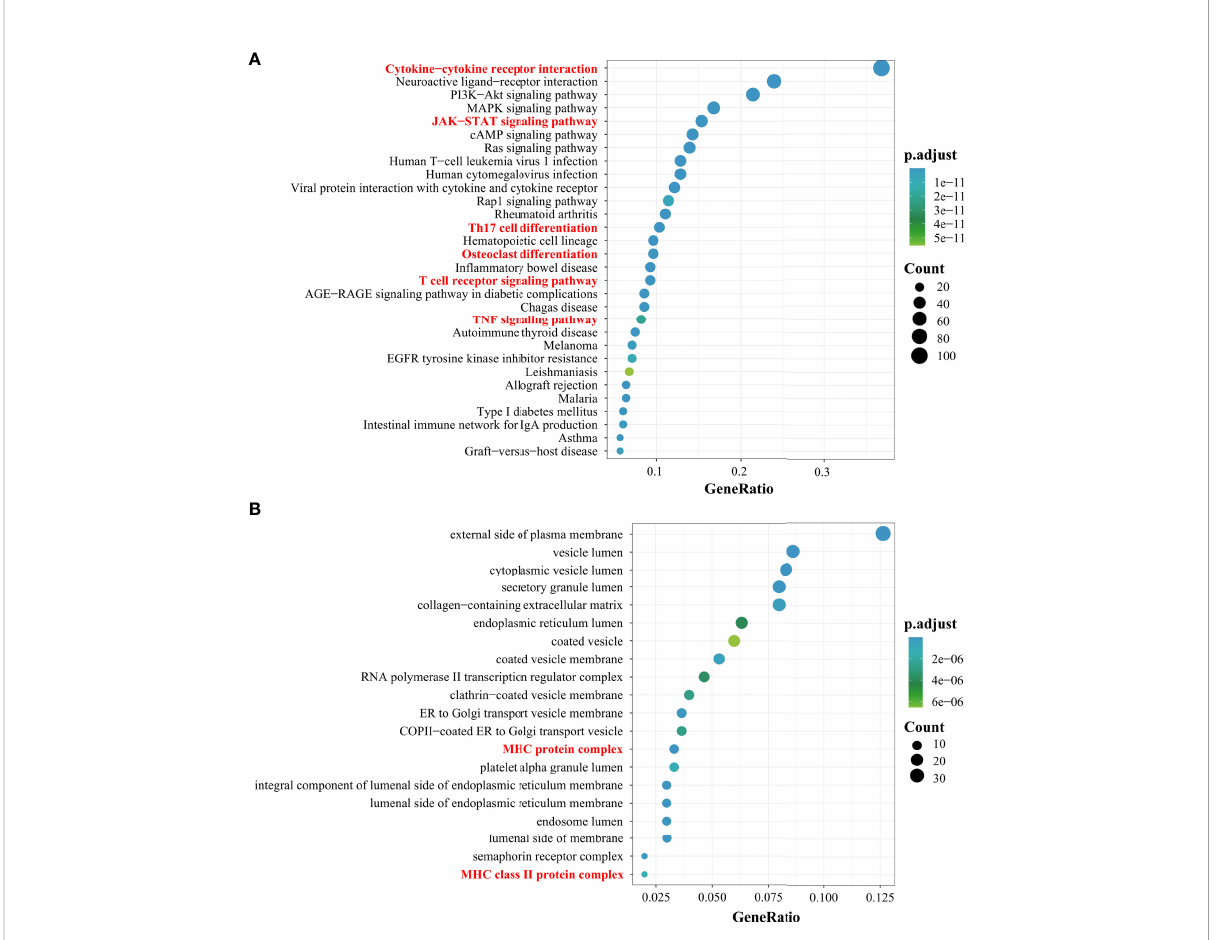
FIGURE 1 Results of the Gene Ontology (GO) and Kyoto Encyclopedia of Genes and Genomes (KEGG) analyses. The top 30 KEGG pathway enrichment candidate targets of the target genes (A) . Pathways with signi fi cant changes (FDR < 0.05) were identi fi ed. The vertical coordinates represent the KEGG pathway with signi fi cant enrichment, and the horizontal coordinates represent the gene ratio which refers to the ratio of enriched genes to all target genes. The top 20 GO enrichment candidate targets of the target genes (B) . The color of the bubble graph indicates the categories of “ cellular components ” in the GO of the target genes (FDR < 0.05), and the horizontal coordinates represent the gene ratio which refers to the ratio of enriched genes to all target